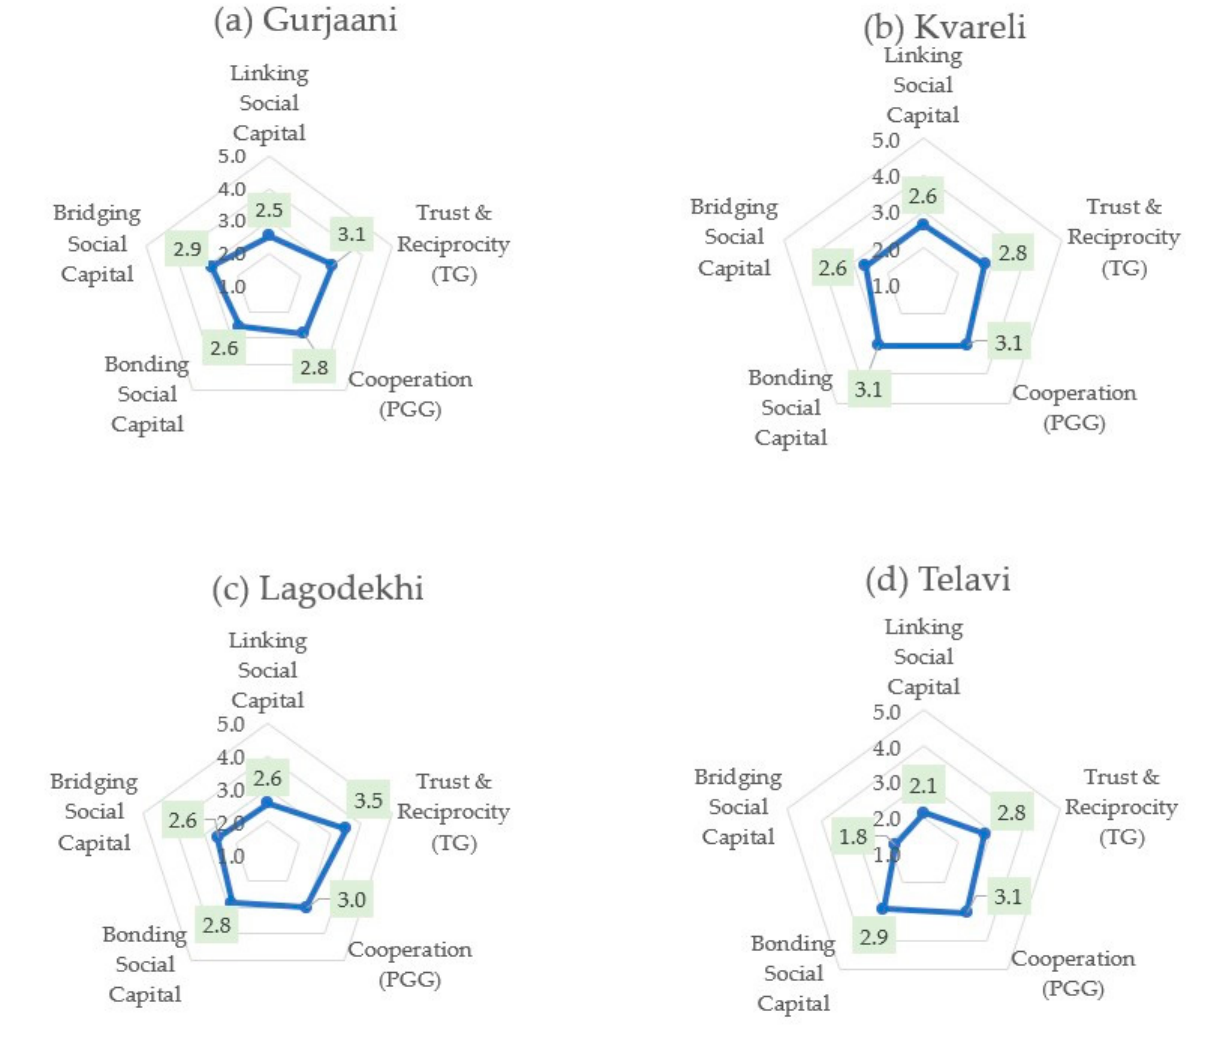
Figure 19. Radar charts of social capital index for different municipalities in Kakheti, Georgia.